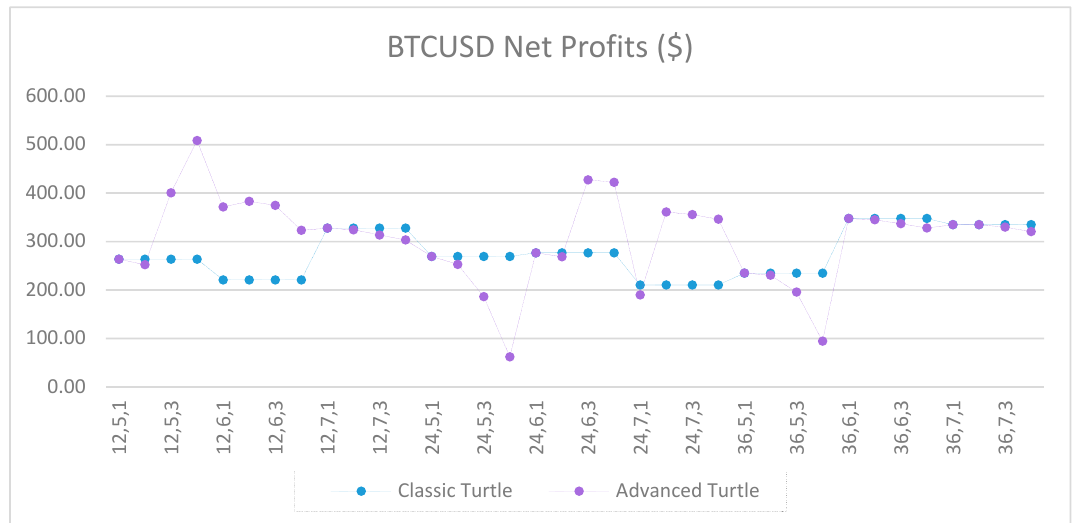
Figure A63. Net profits of BTCUSD between the classic and the advanced Turtle systems for every combination of N, X, Y for the slow parameters (80, 160), where X ≥ 5.